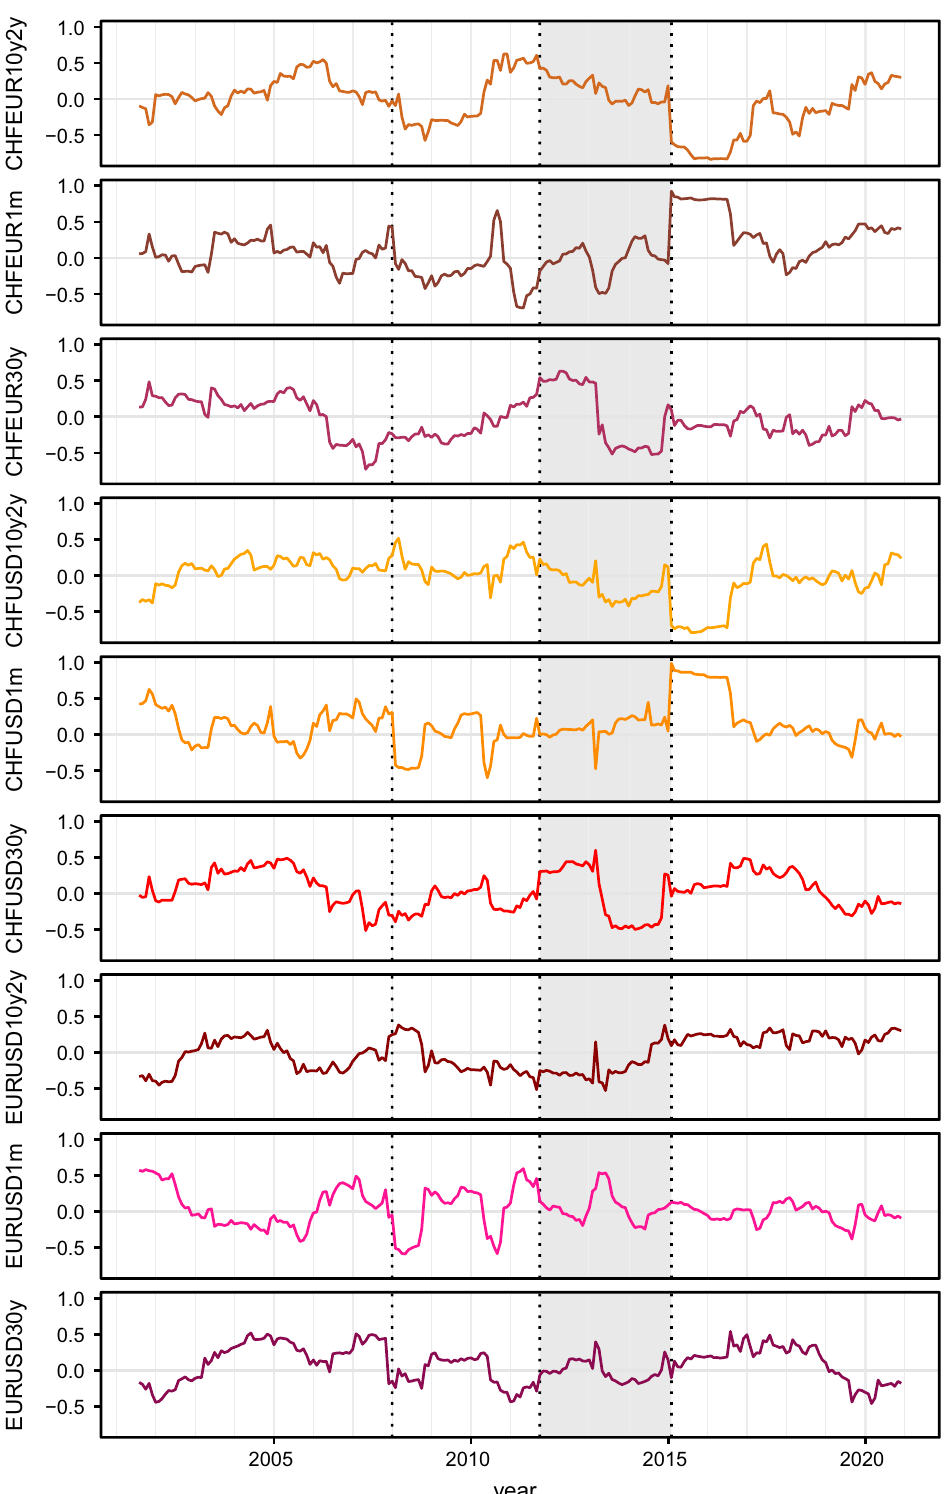
Fig. 3 Rolling window correlations (part 1) between explanatory variables and the EUR/CHF exchange rate for a window size of 18 months. Dotted lines indicate the estimated breakpoints. The shaded area marks the peg